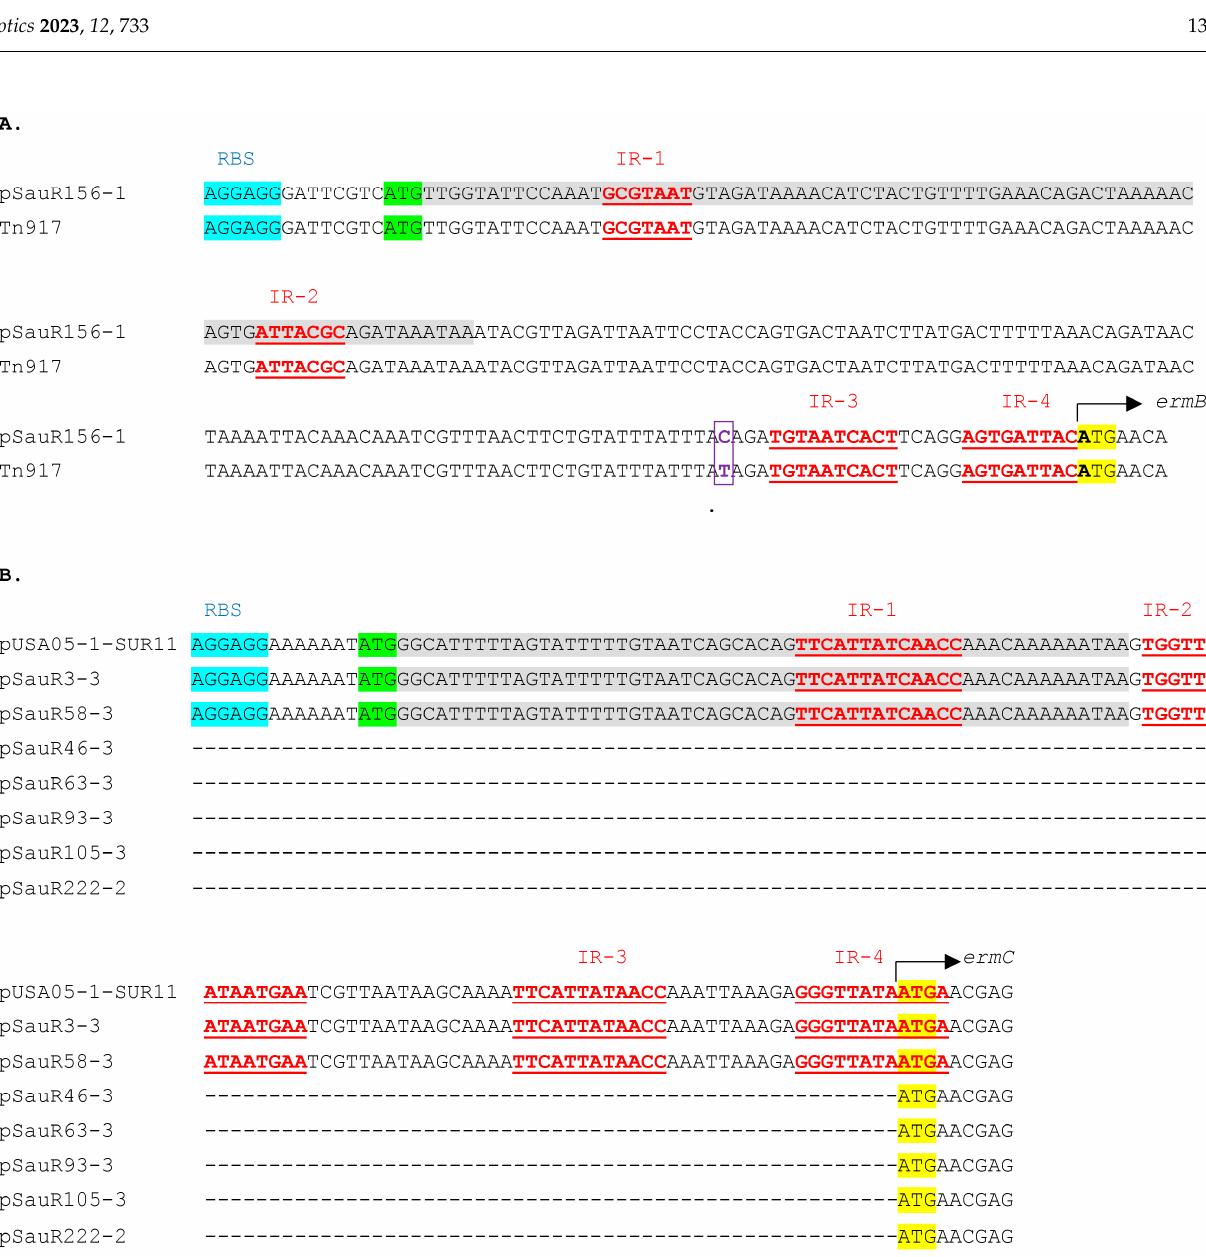
Figure 8. Sequence alignment of ermB and ermC genes in the Malaysian MRSA plasmids in comparison to the reference plasmids. ( A ) Alignment of the ermB leader peptide coding sequence of pSauR156-1 in which the host MRSA strain SauR156 exhibited cMLS B with the ermB leader peptide of an inducible ermB gene carried on transposon Tn 917 . The T > C mutation in pSauR156-1 upstream of the ermB coding sequence is indicated in a purple box. ( B ) Multiple sequence alignment of the ermC leader peptide coding region of pSauR3-3 and pUSA05-1-SUR11 (iMLS B ) and from cMLS B isolates. The start codon of the leader peptide gene is highlighted in green, whereas the start codon of the erm gene is highlighted in yellow. Inverted repeats (IR1–IR4) that enabled the regulation by attenuation mechanism for the erm gene are underlined with red fonts. RBS, ribosomal binding sites, are highlighted in blue. The leader peptide coding sequence is highlighted in grey. Dashed lines indicate deletions.